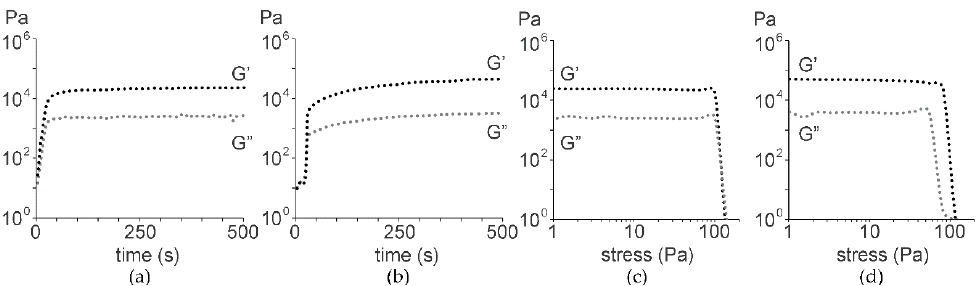
Figure 3. Oscillatory rheometry time sweeps for ( a ) 2 and ( b ) 3 ; stress sweeps for ( c ) 2 and ( d ) 3 .